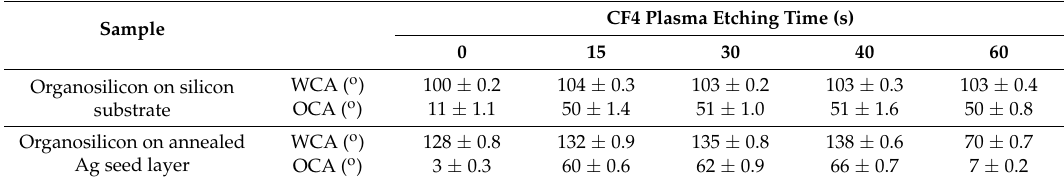
Figure 9. Water contact angles of: ( a ) the organosilicon film directly deposited onto the silicon substrate; and ( b ) the film deposited onto the annealed Ag seed layer after etching by the CF 4 plasma for 40 s; and ( c , d ) the corresponding oleic contact angles (the inset images show the water and oleic droplets on the film surface). Table 3. Water contact angle and oleic contact angle of the organosilicon film directly deposited onto the silicon substrate and deposited onto the annealed Ag seed layer after etching by the CF4 plasma for various